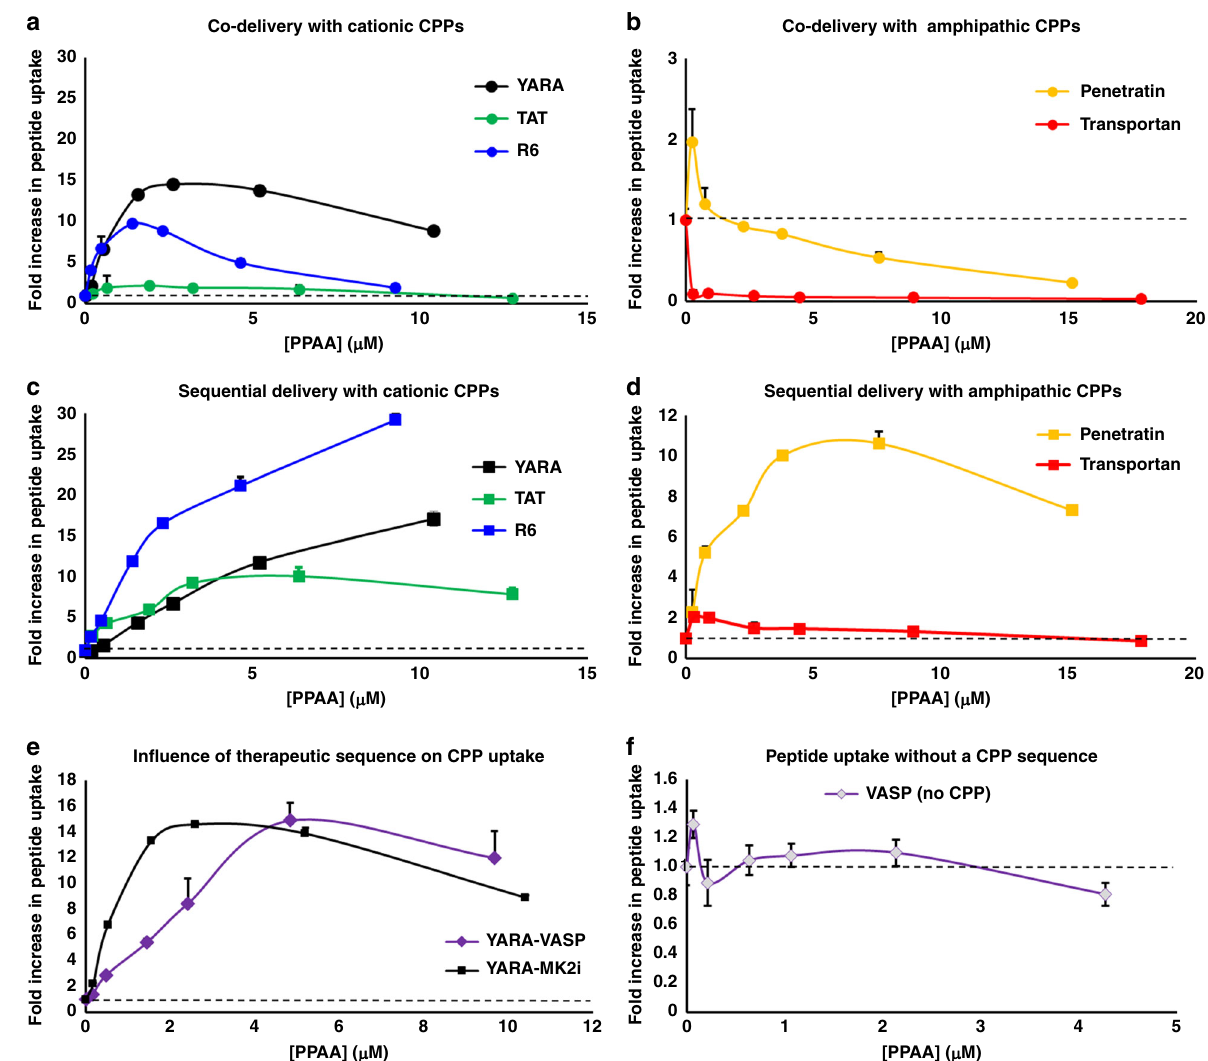
Fig. 1 Sequential delivery is effective across all CPP types. Polymer dose-dependent uptake of the MK2i peptide (co-delivery of pre-complexed polymer/ peptide) fused to a three separate cationic, non-amphipathic CPPs and b two different amphipathic CPPs. Sequential polymer then peptide delivery polymer dose-dependent uptake of the MK2i peptide fused to c three separate cationic, non-amphipathic CPPs and d two different amphipathic CPPs. e Polymer dose-dependent uptake of the YARA CPP fused to two separate therapeutic peptide sequences (MK2i and VASP) when co-delivered. f Polymer dose-dependent uptake of the VASP peptide without a CPP. The mass ratios used for all data shown are 3:1, 1:1, 1:3, 1:5, 1:10, and 1:20 peptide:polymer. Error bars represent SEM. Non-normalized uptake for all data presented in this fi gure is shown in Supplementary Fig.